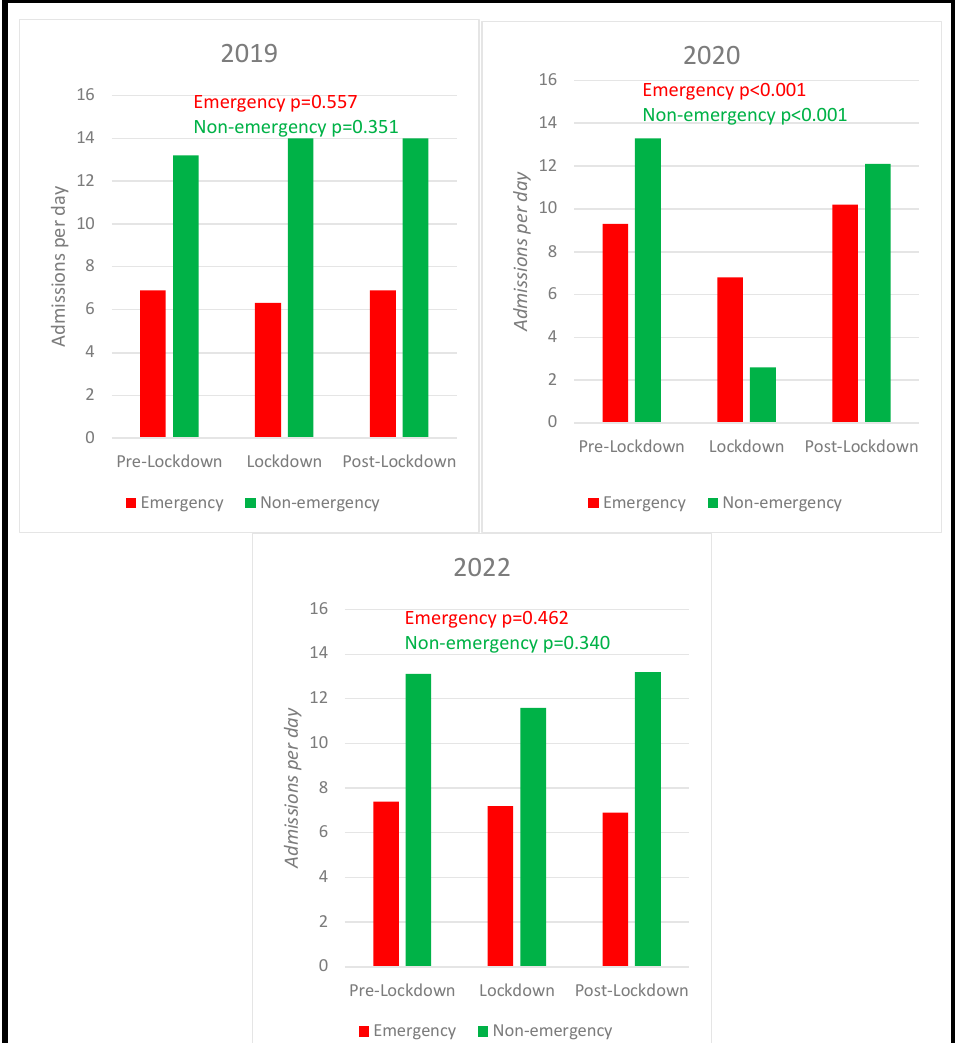
Figure 3. Mean admission numbers per day during each period in 2019, 2020 and 2022 stratified by emergency and non-emergency. Pre-Lockdown (1 January to 19 March), Lockdown (20 March–19 April) and Post-Lockdown (20 April to 30 June).